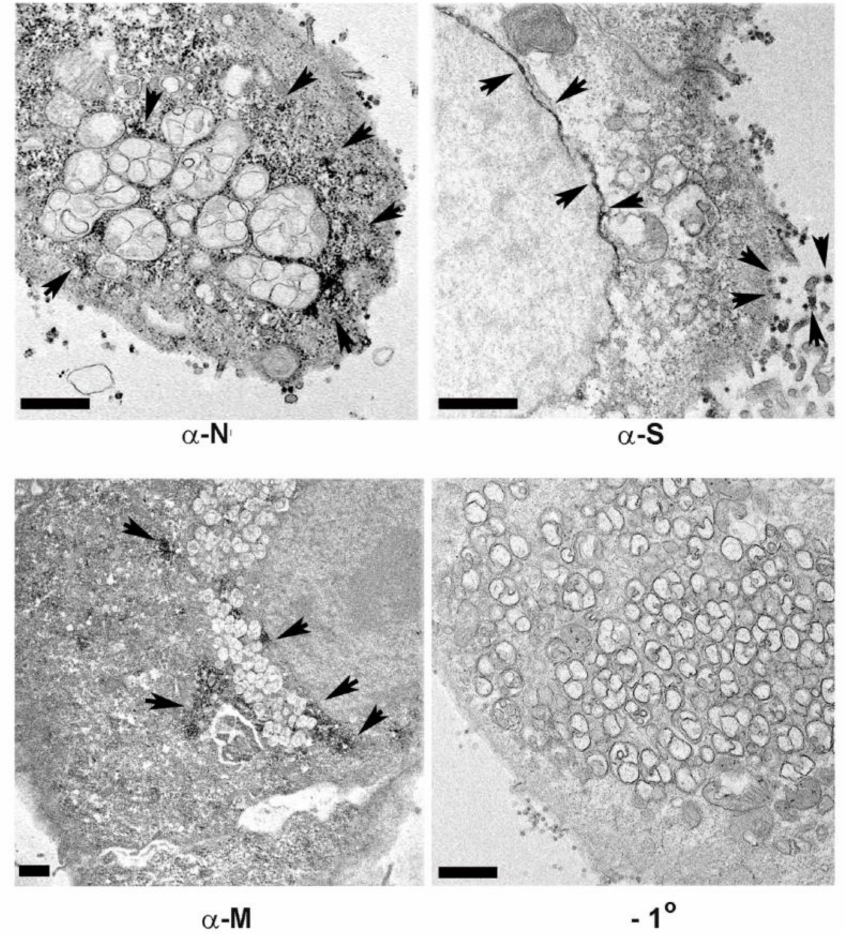
Figure 3. Immunoelectron microscopy localization of viral structural antigens in Vero E6 cells fixed at 24 h post-infection for horseradish peroxidase secondary antibody labeling with diaminobenzidine staining. Dark reaction product indicates localization of the antigen. Shown are anti-nucleocapsid (N), Spike protein (S), and Membrane glycoprotein (M). A panel showing negative staining in the absence of the primary antibody is shown ( − 1 ◦ ). Arrowheads indicate regions of HRP-DAB labeling. Bars = 1 µ